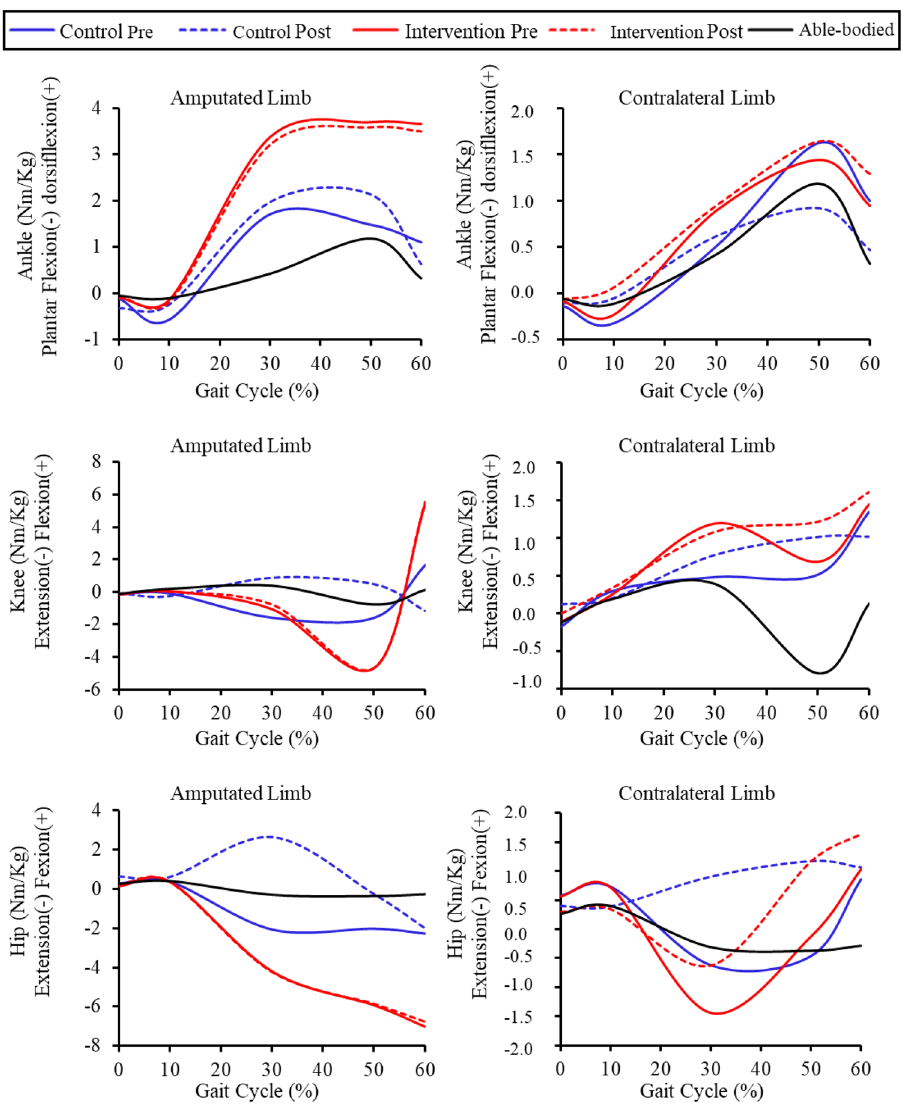
Figure 4. Ankle, knee and hip joint moment variation in the sagittal plane during gait cycle, in each group with amputation pre- and post-intervention. Able-bodied group parameter from their dominant limb is added for